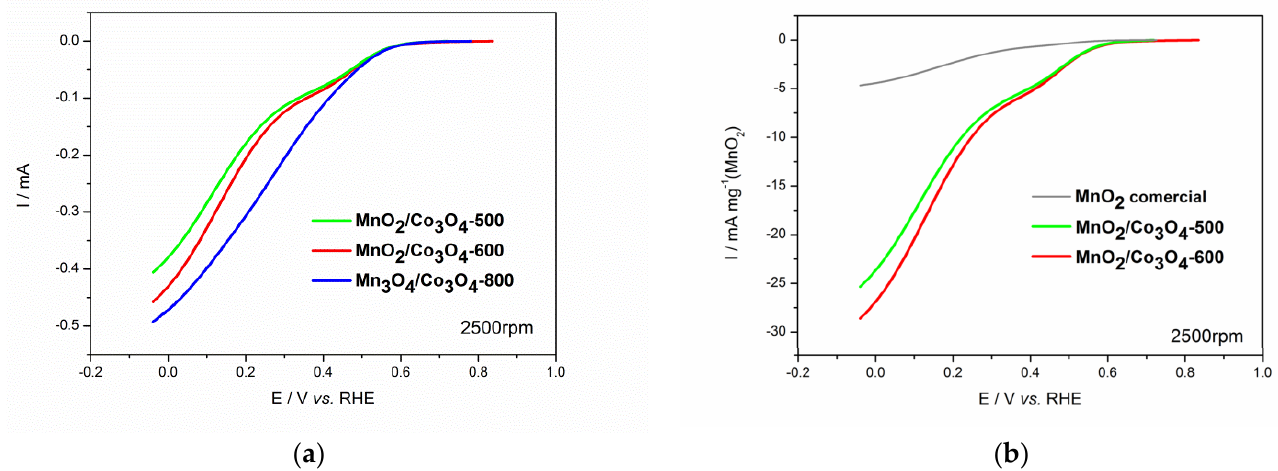
Figure 5. Comparison of ORR activities of Mn-based hybrid materials: ( a ) at different synthesis temperature and ( b ) commercial MnO 2 for ORR per mass of MnO 2 .